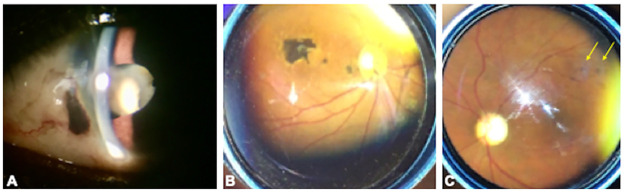
Spectrum of ophthalmic findings in Lassa fever (Lassa fever) survivors.(A) A Lassa fever survivor with a history of a penetrating corneal injury shows uveal prolapse nasally, traumatic cataract and focal posterior synechiae temporally. (B) Another Lassa fever survivor shows macular chorioretinal scar and smaller satellite lesions temporal to the nerve. The visual acuity was 20/200. (C) One Lassa fever survivor shows multifocal scars varying from 100–200 microns within the superotemporal arcade (yellow arrows) but the fovea is spared.